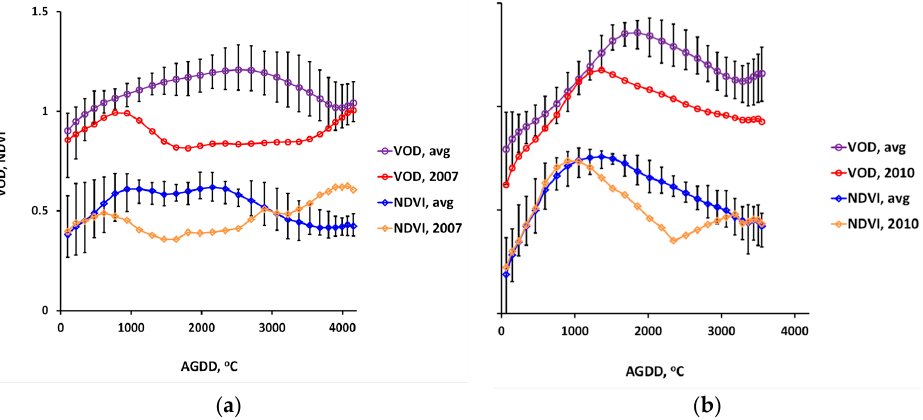
Figure 14. VOD and NDVI plots for sample sites: ( a ) Mykolayiv, UA; and ( b ) Voronezh, RU, affected by the 2007 and 2010 Ukrainian and Russian heatwaves, respectively. In both plots, purple circle represents VOD at 10.65 GHz and blue diamond represents NDVI plots average (2003–2010) excluding the respective heatwave years with relative maximum and minimum error bars. The red circle and orange diamond plots represent heatwave year VODs and NDVIs, respectively, for both sites. Note the PH in both the average and heatwave affected years. Note also the shapes and magnitudes of the time series in the heatwave years relative to the other year’s average.